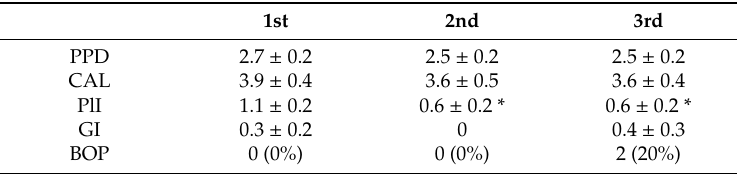
Table 3. Changes in clinical parameters at HC sites.